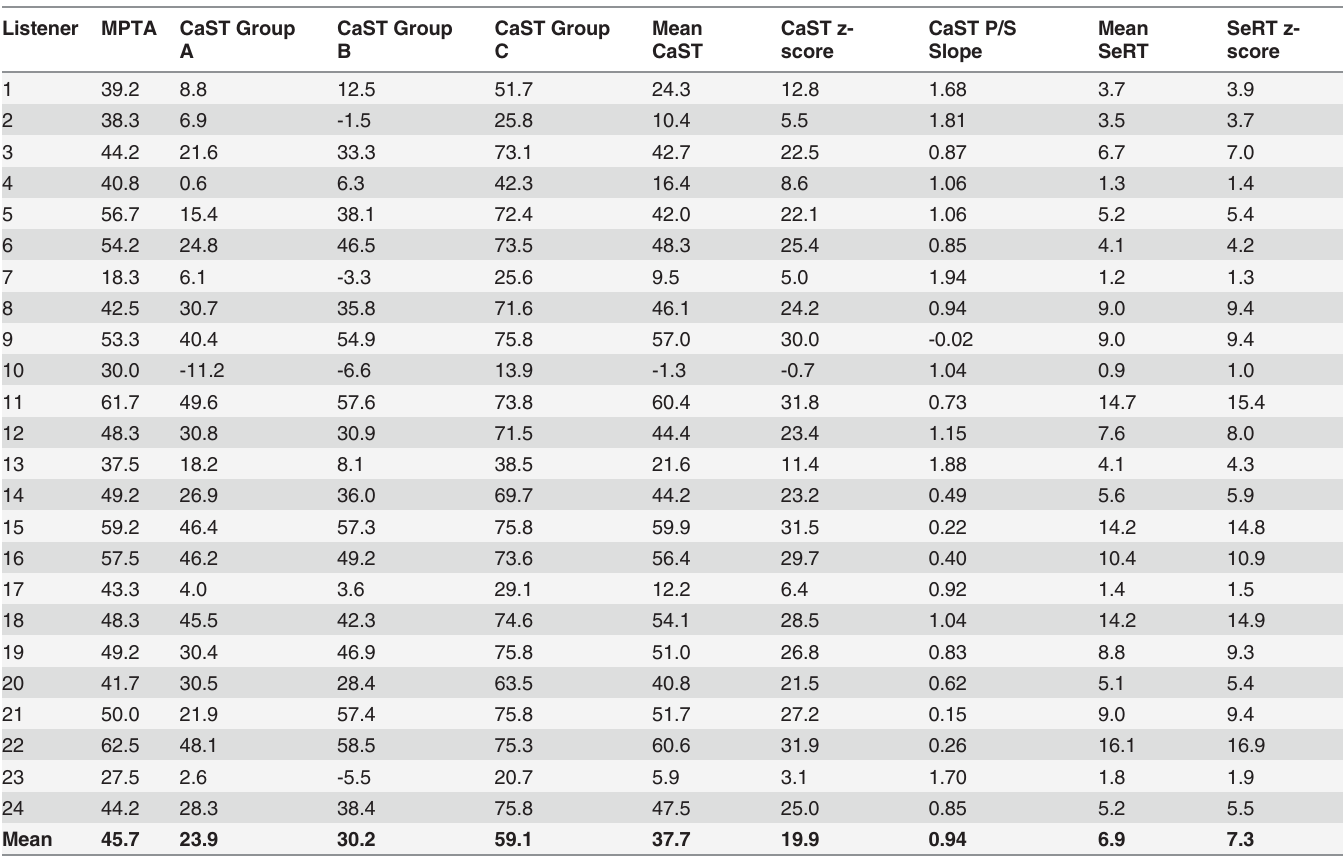
Table 1. Mid-frequency PTA (MPTA), unaided consonant identi fi cation threshold elevations (re: ONH listeners) for Groups A, B, and C consonants, mean consonant identi fi cation threshold elevations, and z-score elevations for OHI listeners. Listener MPTA CaST Group